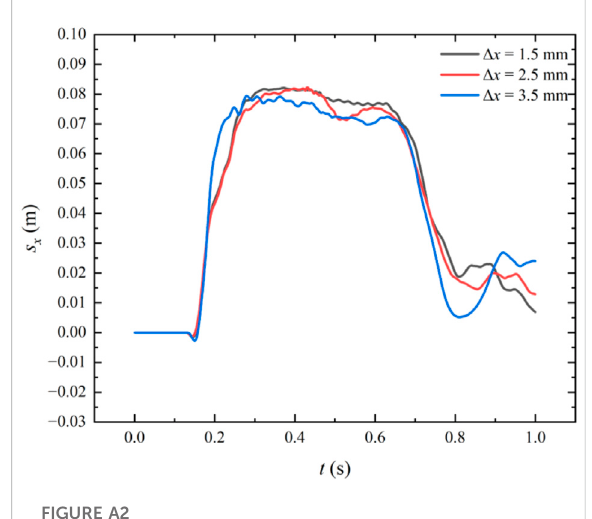
FIGURE A2 The time history of horizontal displacement of the upper left corner of the elastoplastic baf fl